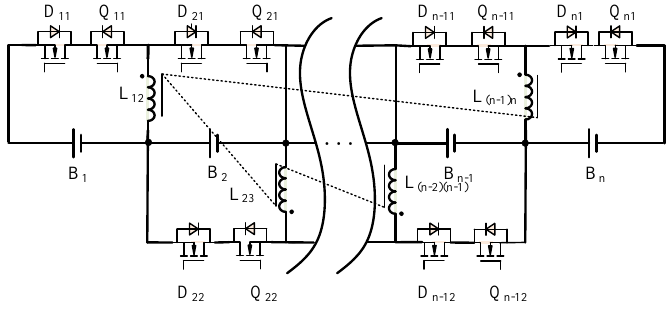
Figure 3. Main circuit for series connected batteries.